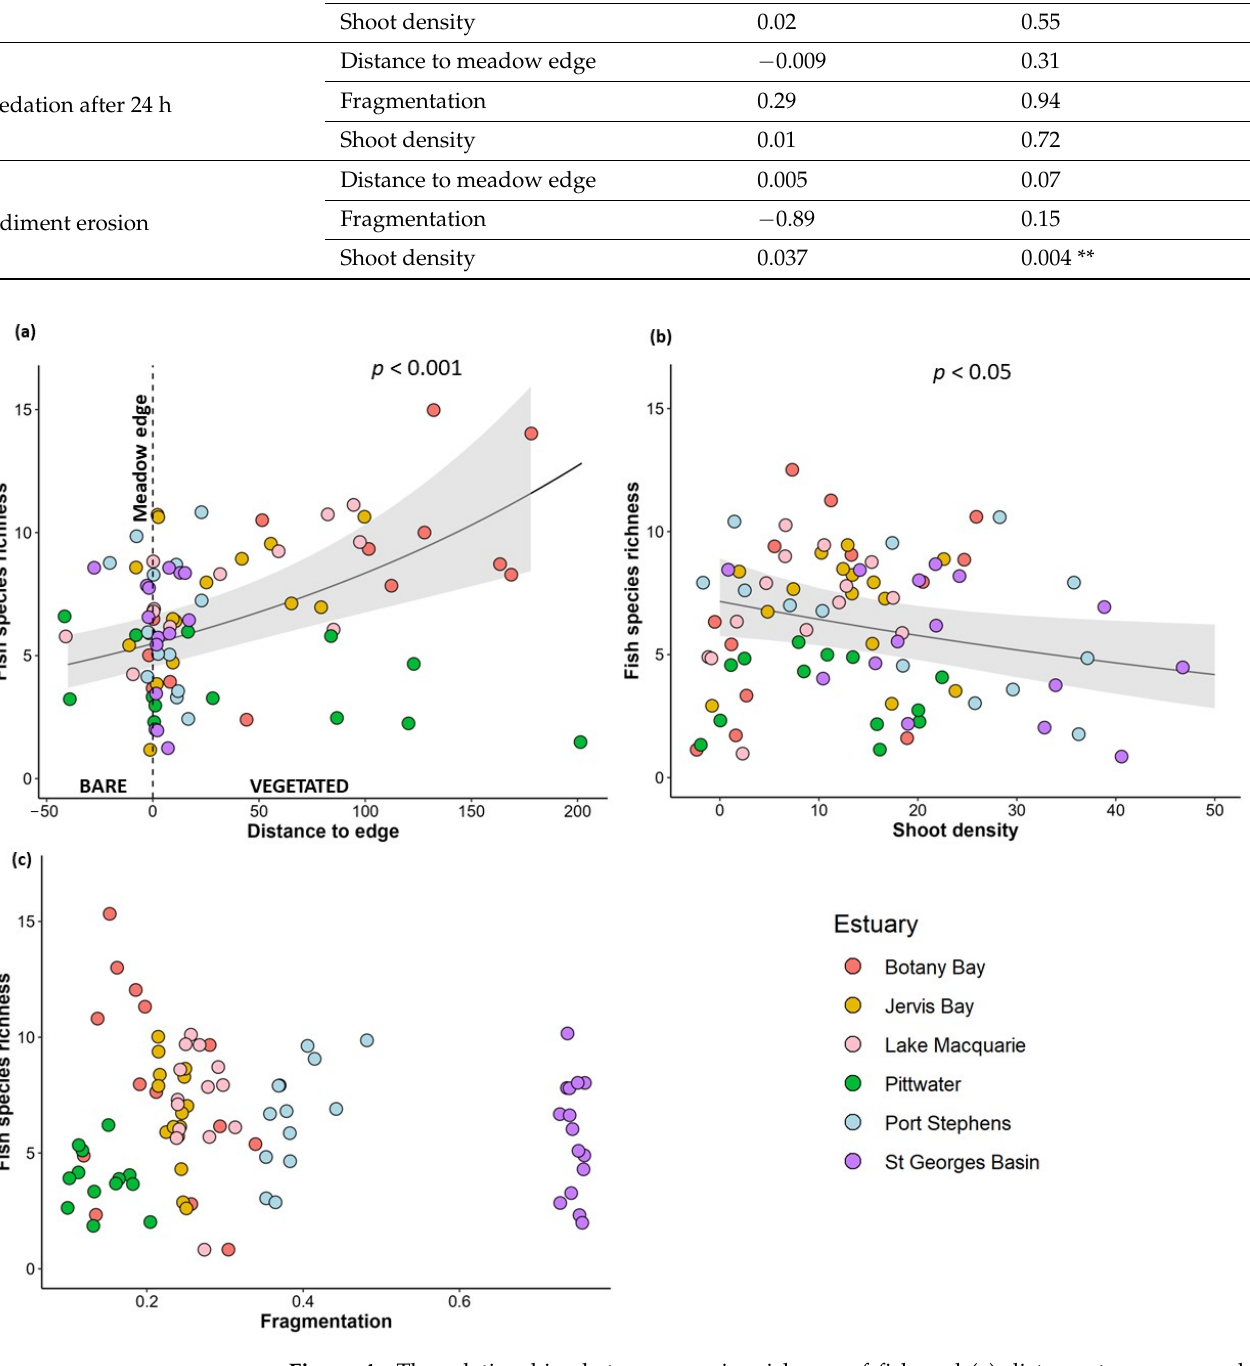
Figure 4. The relationships between species richness of fish and ( a ) distance to seagrass edge, ( b ) P. australis shoot density/0.0625 m 2 and ( c ) seagrass fragmentation. Color patterns and figure details are described in Figure